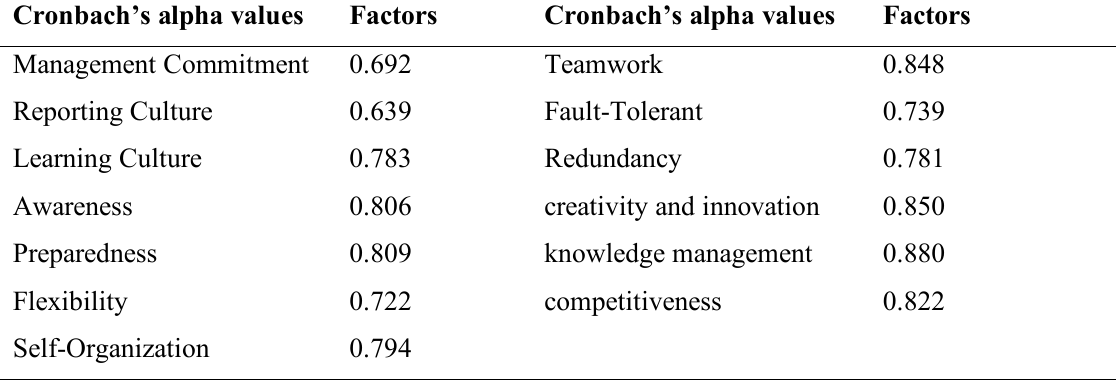
Table 1. The values of Cronbach’s alpha for all